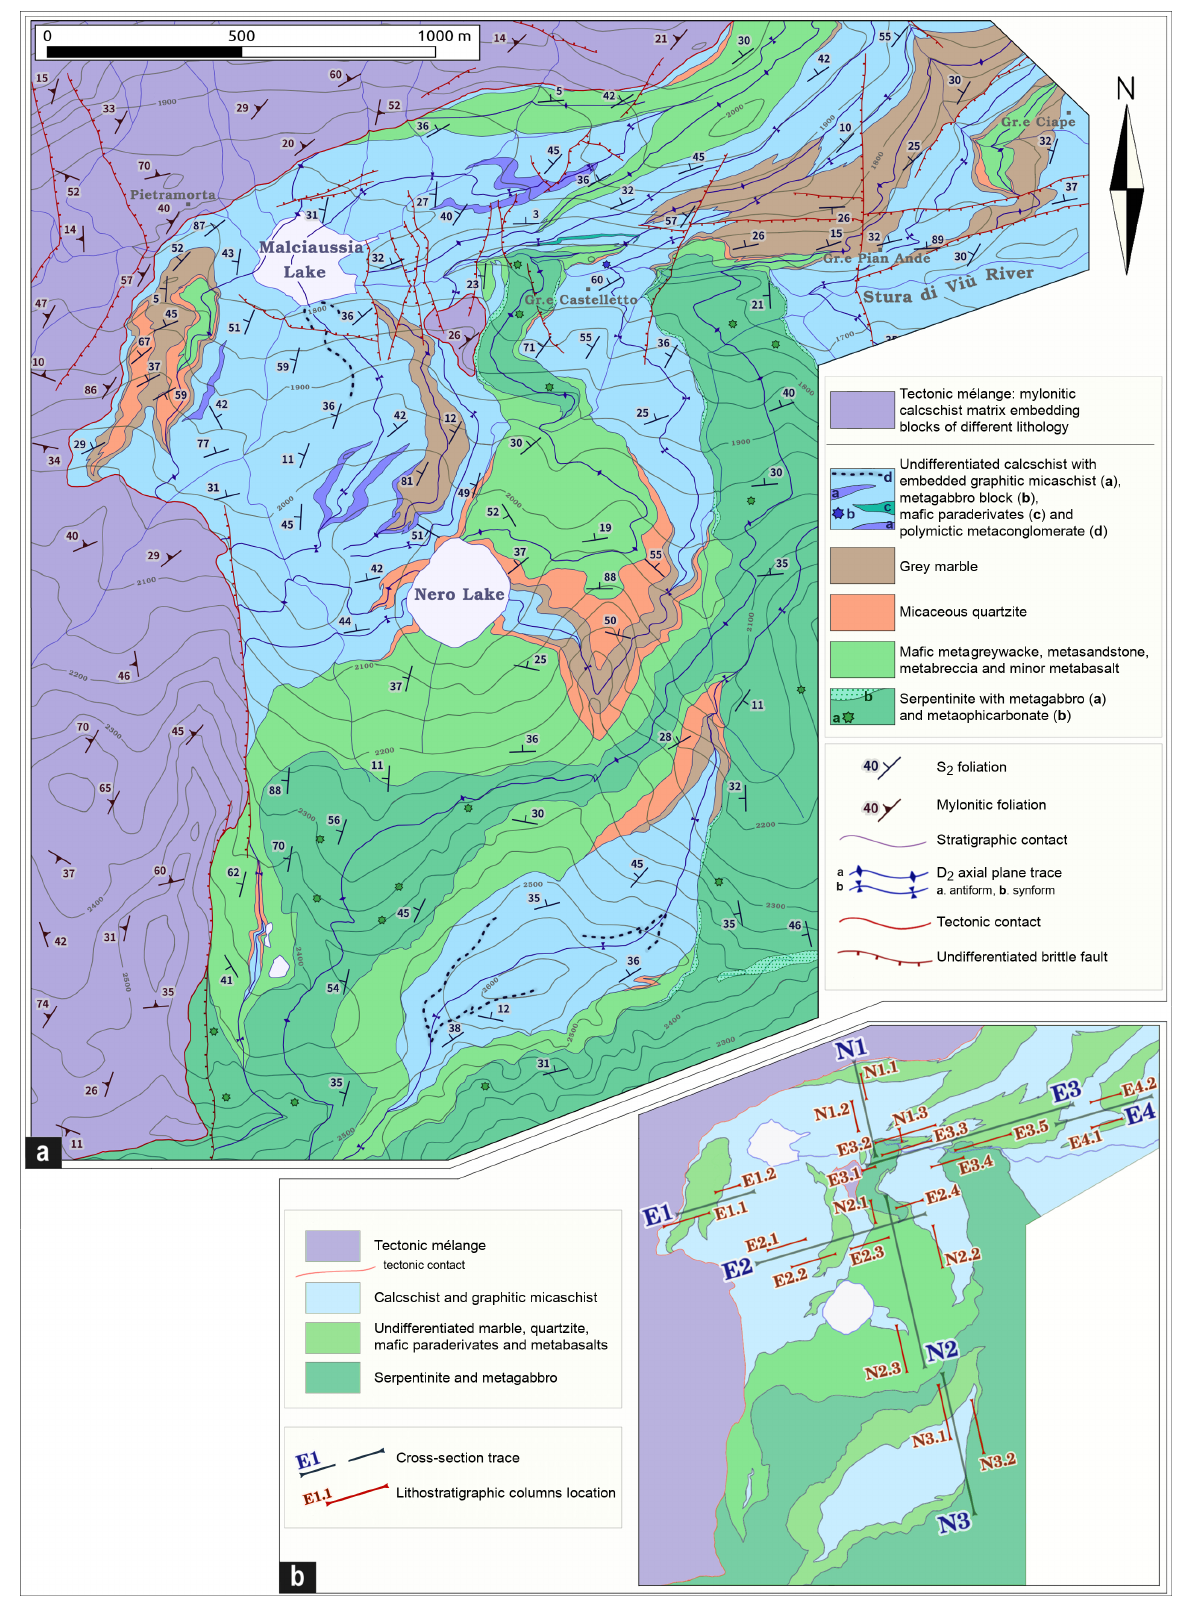
Figure 2. ( a ) Simplified geological map (1:10,000 scale) of the study area. ( b ) Schematic map showing the location of cross sections and lithostratigraphic columns. Schematic cross sections are shown in Figure 3. An integrated geological map showing the location of cross sections and lithostratigraphic columns is reported in Figure